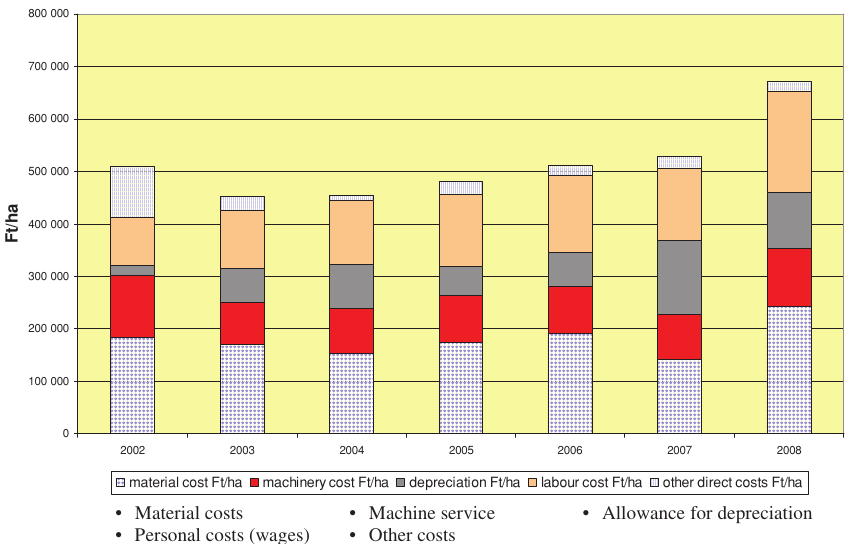
Figure 1. Composition of immediate costs of apple production in the relevant apple growing enterprises